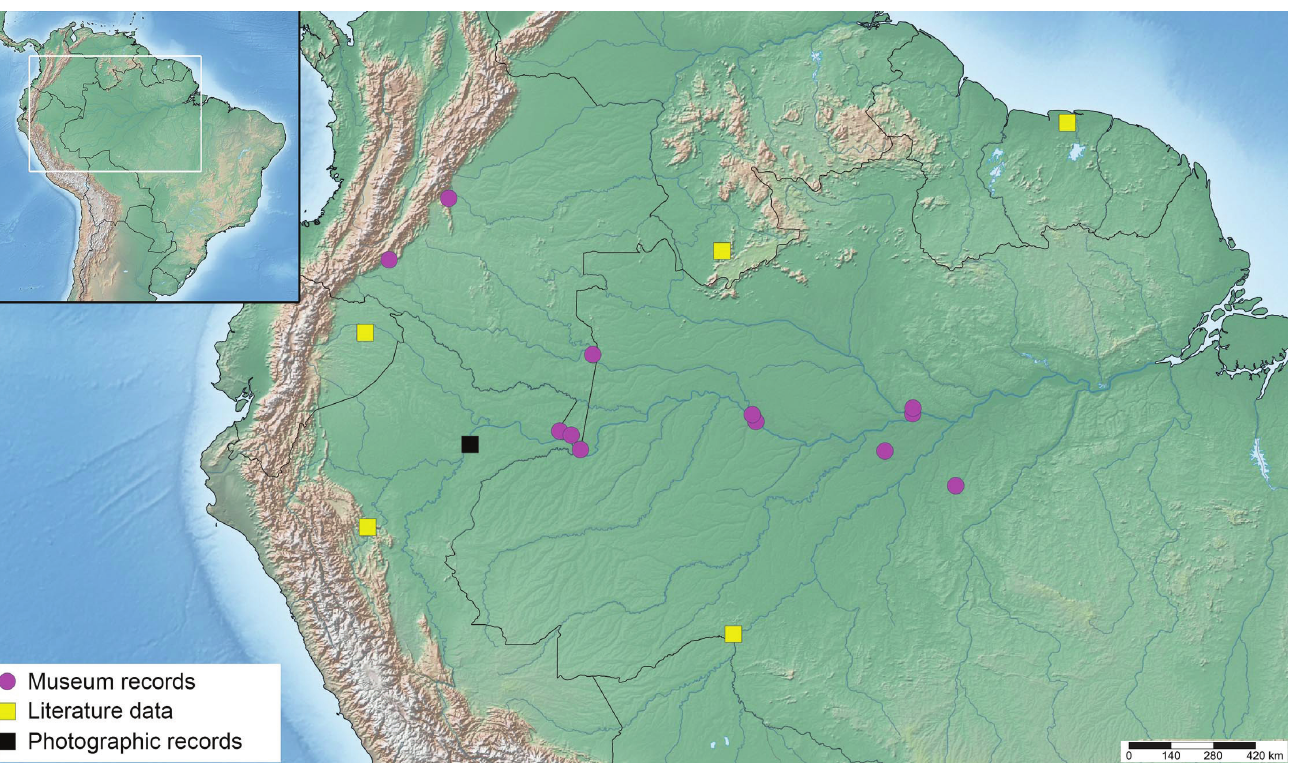
Fig. 14. Eomorphopus antennatus